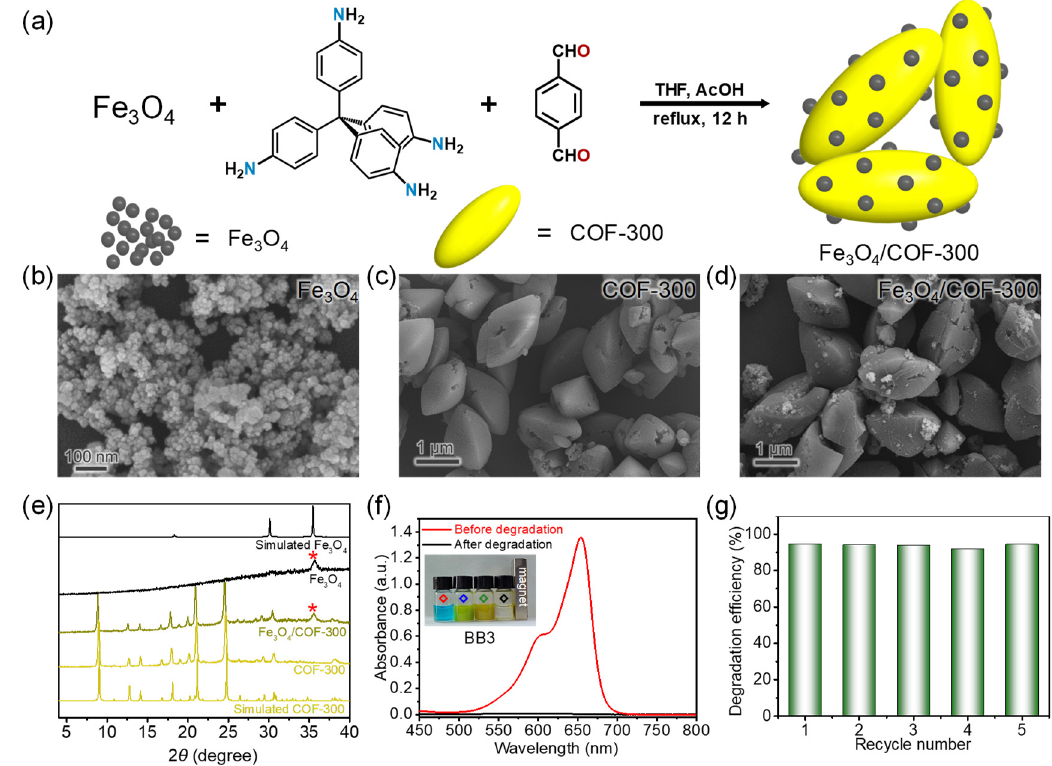
Figure 8. ( a ) Synthetic route of Fe 3 O 4 /COF-300 nanocomposites; ( b – d ) SEM images of Fe 3 O 4 , COF- 300 without adding Fe 3 O 4 , and Fe 3 O 4 /COF-300; ( e ) PXRD pattern comparison for Fe 3 O 4 /COF-300; ( f ) UV–vis absorption spectra of BB3 aqueous solutions (Inset shows the photographs of the BB3 solu- tions. Red: blank; blue: adding Fe 3 O 4 /COF-300 nanocomposites; green: after 6 h UV light irradiation; black: after magnetic recovery); ( g ) Recyclability of Fe 3 O 4 /COF-300 for BB3 photocatalytic degrada- tion.